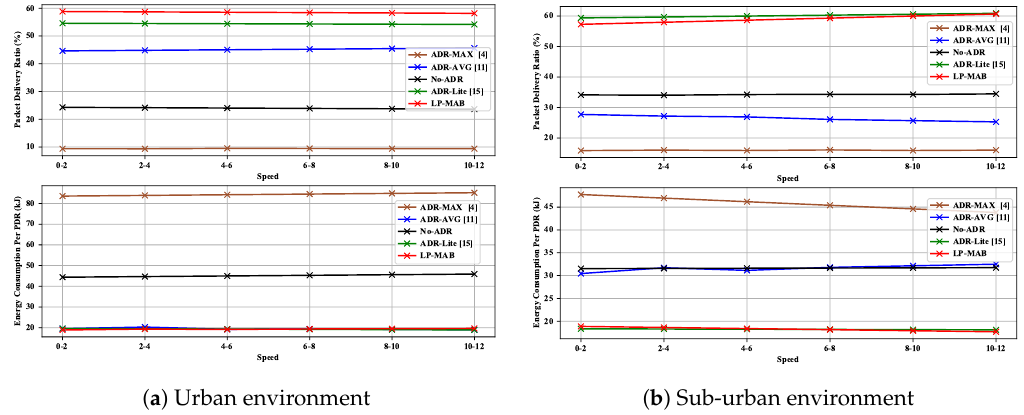
Figure 11. PDR & EC versus different values for speed for mobile EDs in Scenario